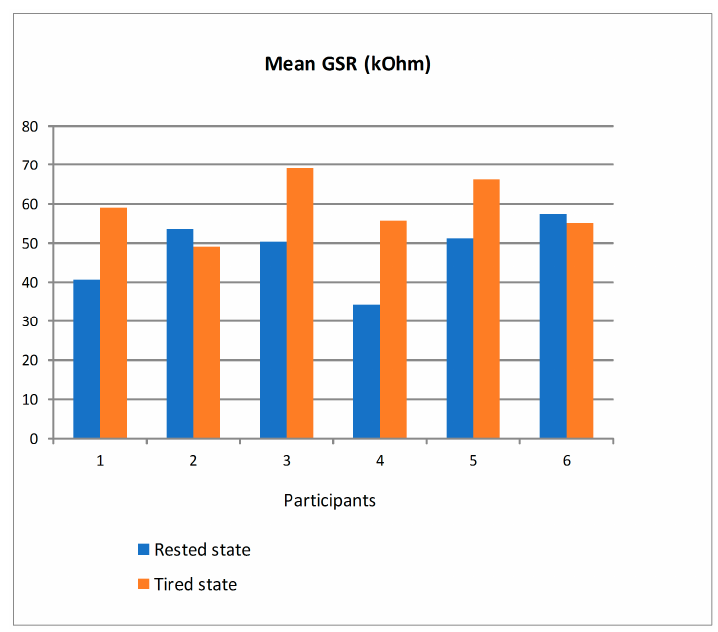
Figure 20. Mean GSR of the participants in rested and tired state.